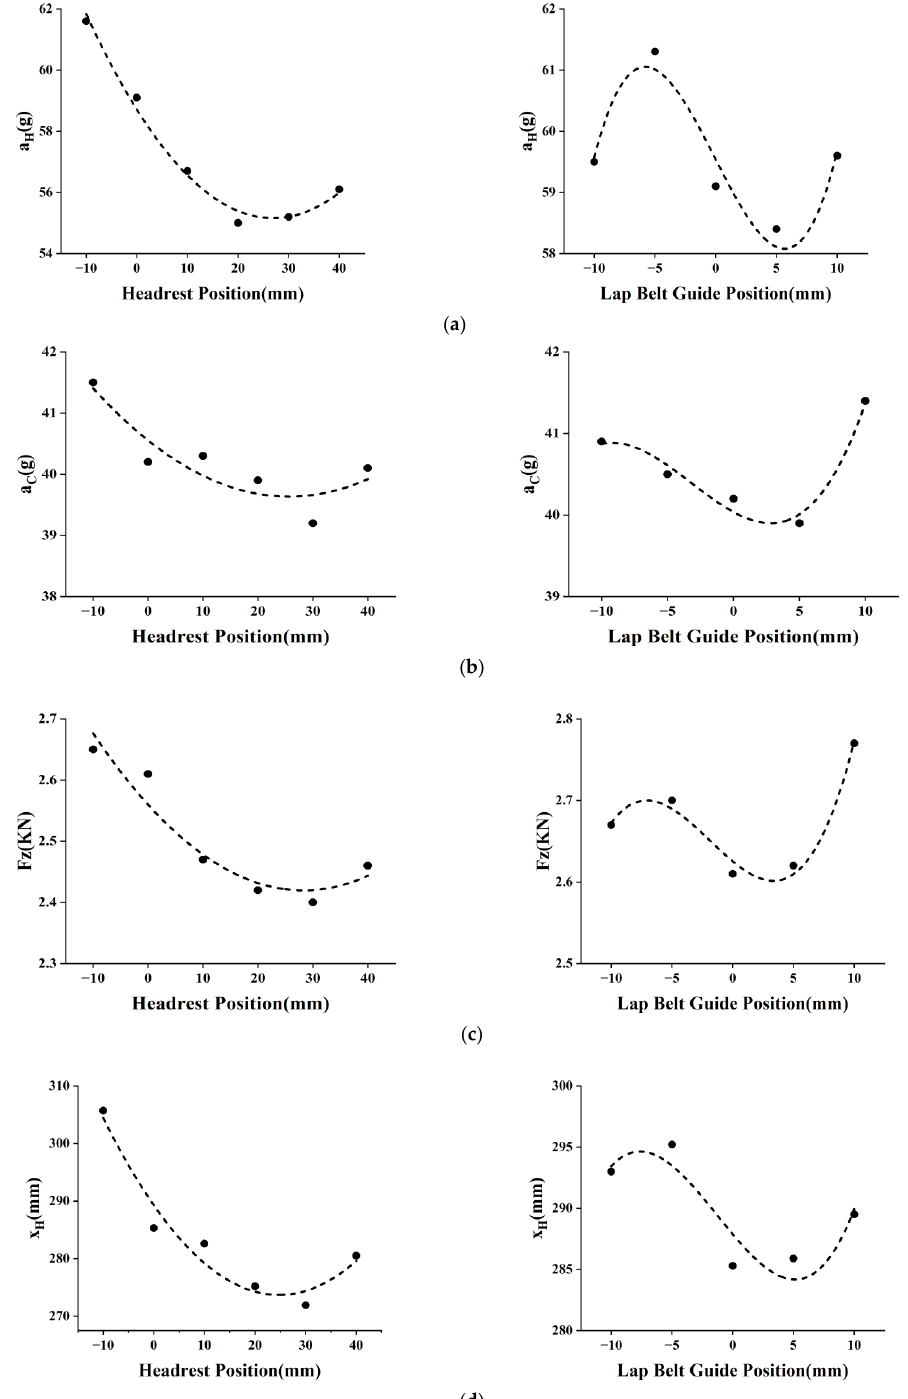
Figure 9. A value of ( a ) 3 ms head resultant acceleration 𝑎 𝐻 variation due to the lap belt guide po- sition (Left) and the lap belt guide position (Right); ( b ) 3 ms chest resultant acceleration 𝑎 𝐶 variation due to the lap belt guide position (Left) and the lap belt guide position (Right); ( c ) upper neck tension 𝐹 𝑍 variation due to the lap belt guide position (Left) and the lap belt guide position (Right); ( d ) the head horizontal displacement 𝑥 𝐻 variation due to the lap belt guide position (Left) and the lap belt guide position (Right).